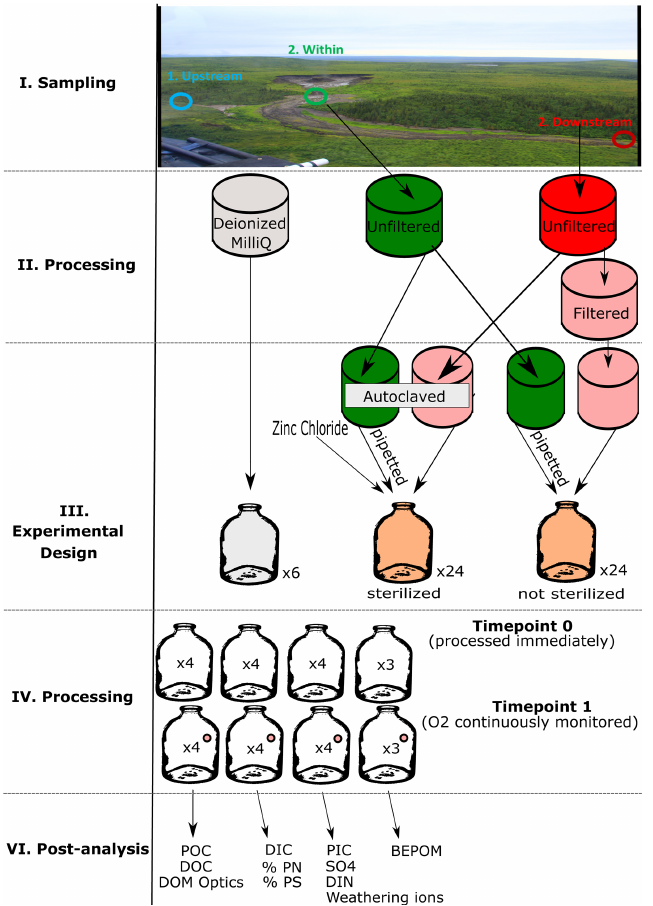
Figure D1. Flow chart for processing of 2019 experiment. Note that only two bottle replicates were used to assess changes in base-extracted particulate organic matter (BEPOM) for sterilized treatments. Analyses show particulate (POC) and dissolved (DOC) organic carbon, dis- solved organic matter (DOM) optics (absorbance and fluorescence), dissolved (DIC) and particulate (PIC) inorganic carbon, percent partic- ulate nitrogen (PN) and sulfur (PS), dissolved inorganic nitrogen (DIN), SO 2 − , weathering ions, and 4